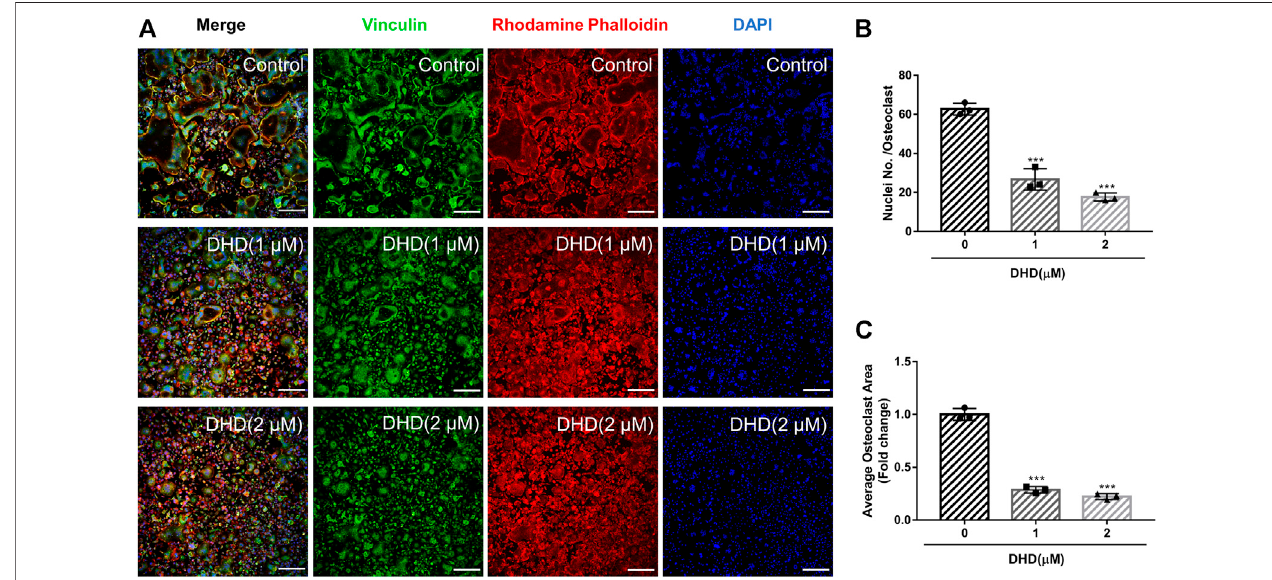
FIGURE 2 | DHD represses RANKL-induced osteoclasts fusion. (A) Representative confocal images of osteoclasts stained for vinculin (green), F-actin belts (red) and nuclei (blue) (scale bar = 200 μ m). (B,C) Quanti fi cation of the osteoclasts per area and the mean number of nuclei per in each cell.